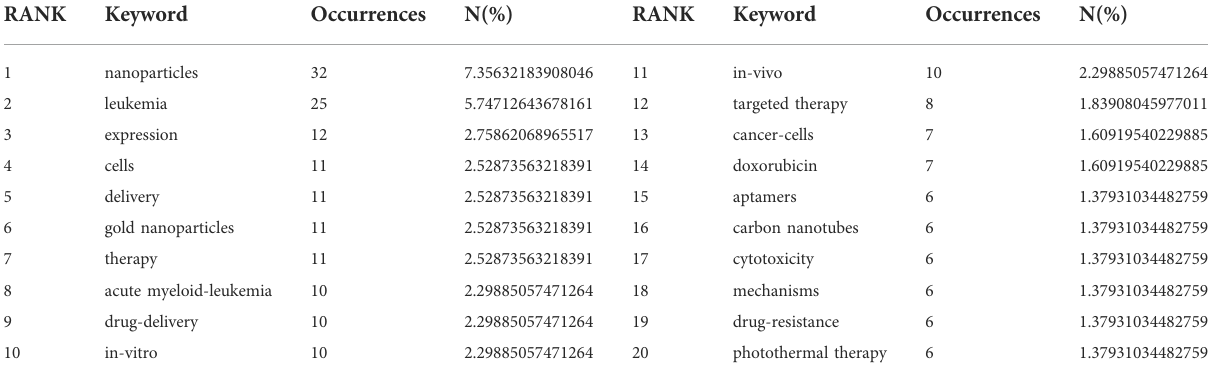
TABLE 9 The top 20 keywords of top100 cited articles